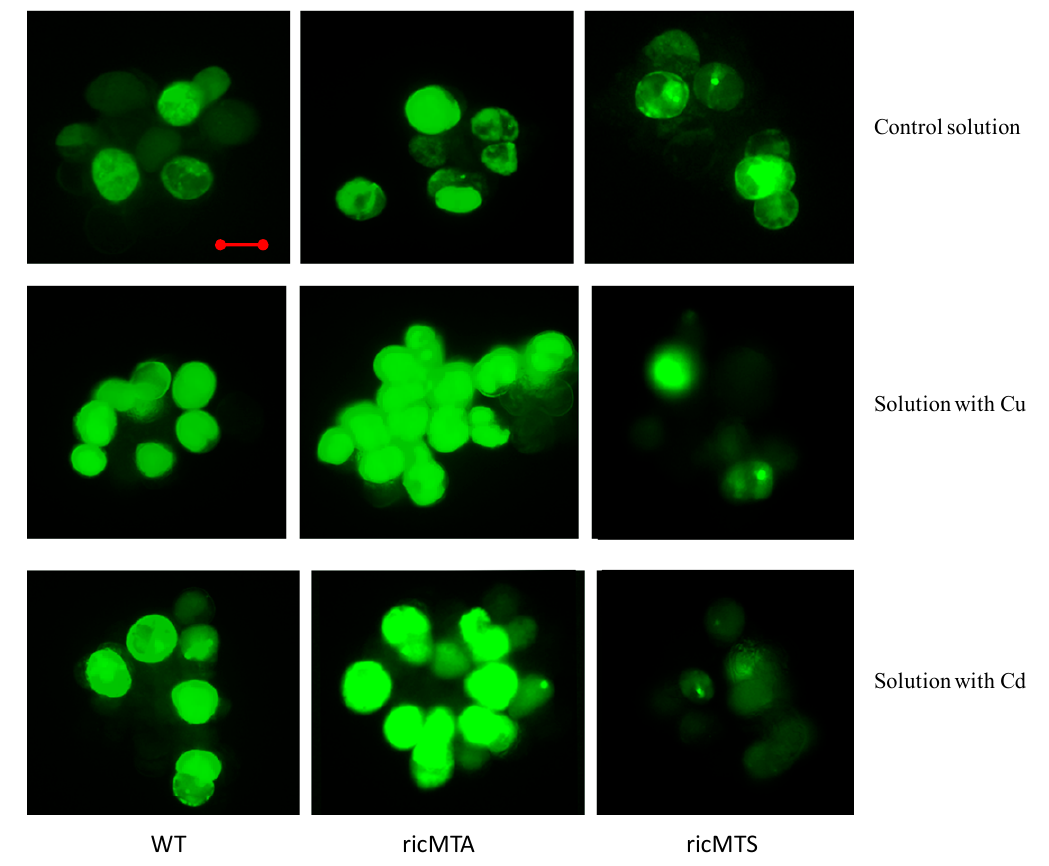
Figure 5. Effect of treatment of Cu or Cd on H 2 O 2 production of rice suspension cells. Rice suspension cells were cultured with control medium, or medium with 100 µ M CuSO 4 or medium with 100 µ M CdCl 2 for 24 h. Subsequently, the suspension cells were incubated in 20 µ M H 2 DCFDA for 20 min. WT represents the wild-type rice suspension cells; ricMTA and ricMTS respectively represent rice suspension cells of the antisense- ricMT line and sense- ricMT line. Bar, 20 µ m. Experiments were repeated at least three times with similar results.